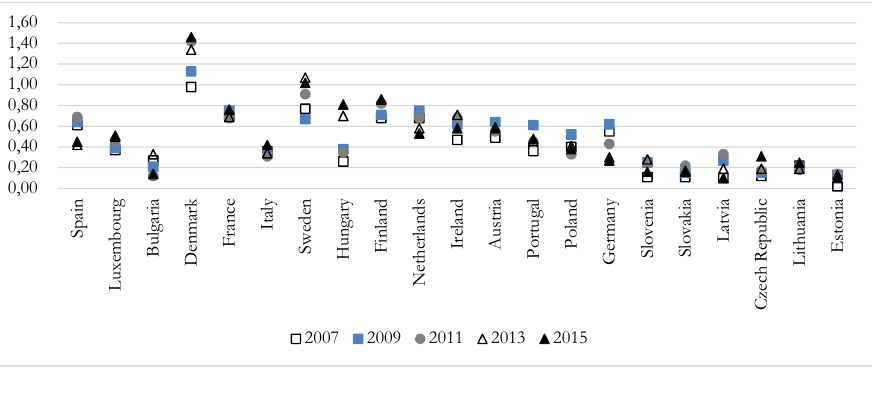
Fig. 1 – Expenditures on ALMPs, 2007 – 2015, % of GDP. Source: Eurostat